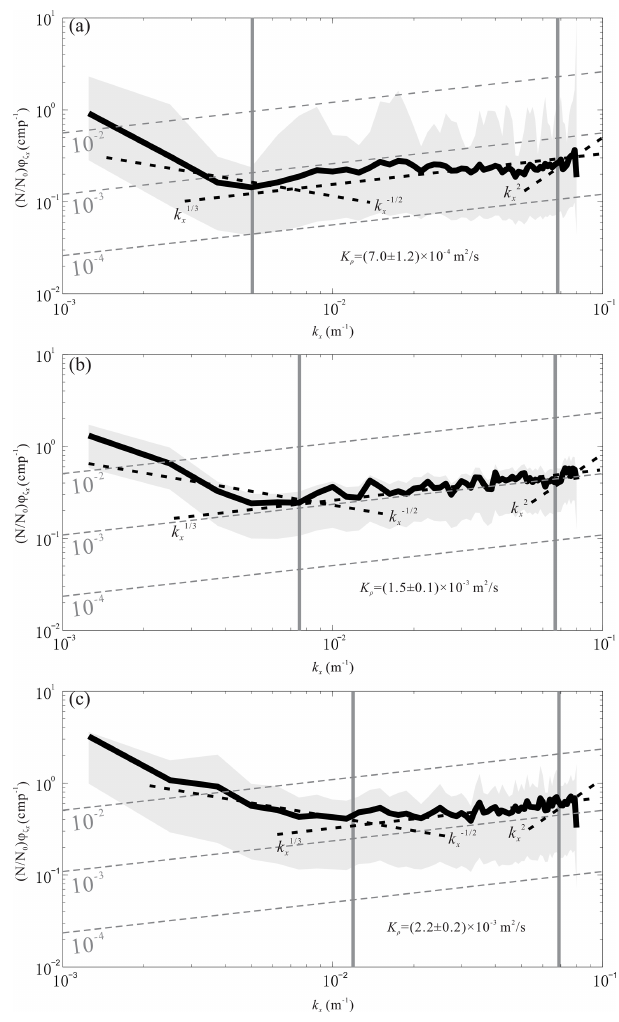
Figure 6. The average horizontal slope spectra of the L1 section (a) , L2 section (b) and L3 section (c) . The black line is the spectrum, the gray shadow represents the 95% confidence interval, the gray dashed lines represent the diffusivity contour, and the black dashed lines represent the spectral slopes in the internal wave subrange, turbulence subrange and noise subrange, respectively. The gray ver- tical lines label the boundaries of the turbulence